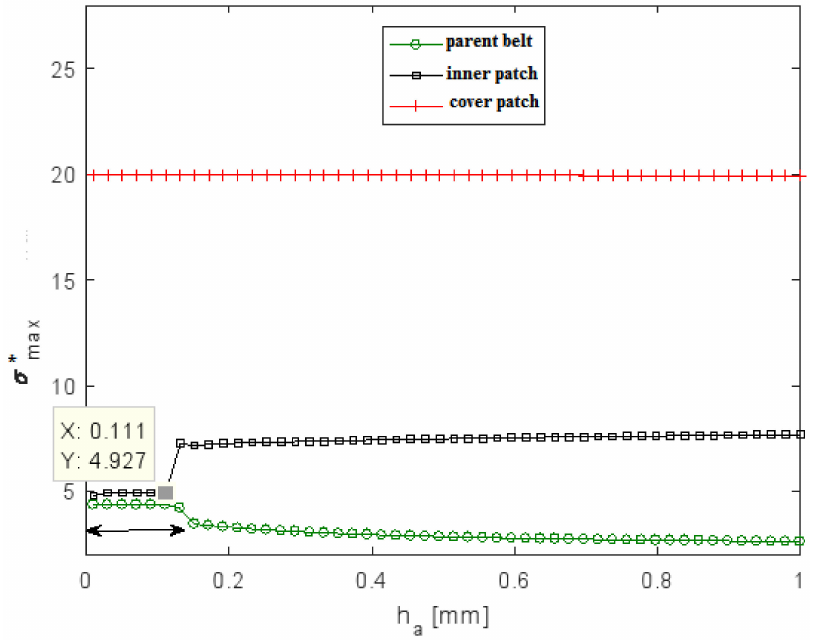
Figure 17. Variation of the maximal normalized normal stress ratio σ ∗ max in adherents as a function of adhesive thickness h a